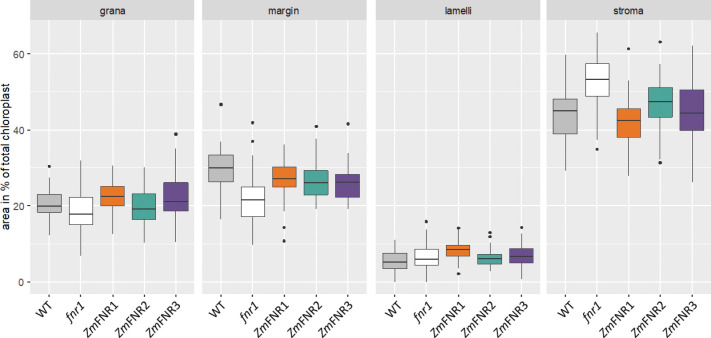
Comparison of areas of different chloroplast sub-compartments between genotypes.Areas of chloroplast sub-compartments were defined as displayed in Figure 1—figure supplement 2, before calculating the percentage area within the chloroplast of each indicated sub-compartment for 15–22 chloroplasts from three individuals each of the indicated genotypes.